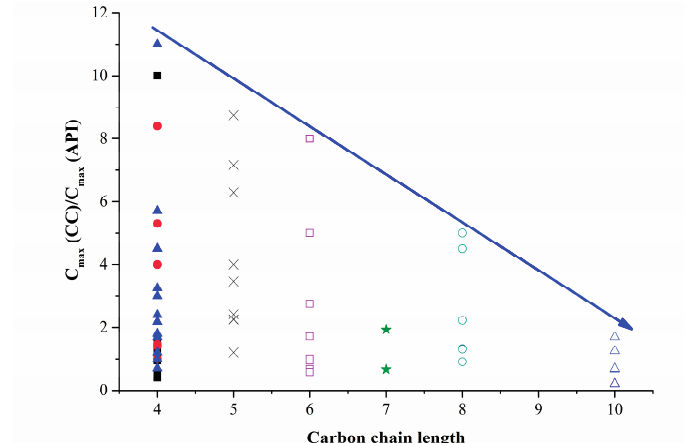
Figure 9. Cocrystal-API solubility ratio as a function of carbon chain length of dicarboxylic acids. The cocrystals and salts with different acids as co-formers are represented by the following symbols: with fumaric ( ■ ); with maleic ( ● ); with succinic ( ▲ ); with glutaric (  ); with adipinic ( □ ); with pimelic (  ); with suberic ( ○ ); and sebacic (  )